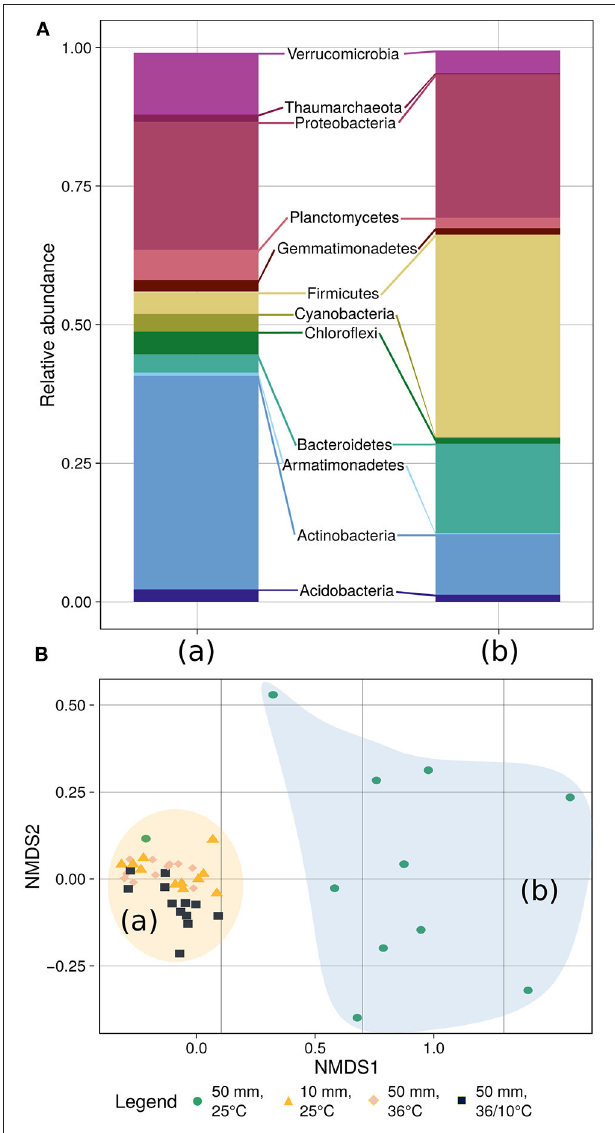
FIGURE 5 | Community composition (A) and NMDS-based clustering analysis (B) of the bacterial population. (A) The community composition analysis differentiates between the soil bacteria response to heavy rain and lower temperature (right bar) and the other three experiments (left bar) where the bacterial community showed marginal differences between experiments (Supplementary Table 3). (B) The diversity analysis underlines the community composition results differentiating between the experiments. Stress of the dimensionality reduction is 0.083, meaning that the plot well represents the data